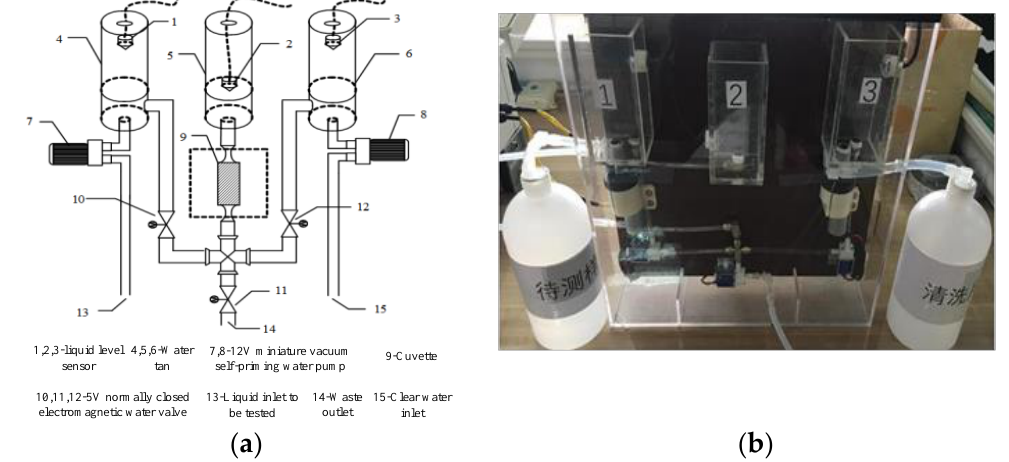
Figure 9. Pipe unit: ( a ) structure diagram; and ( b ) pipe unit photograph.